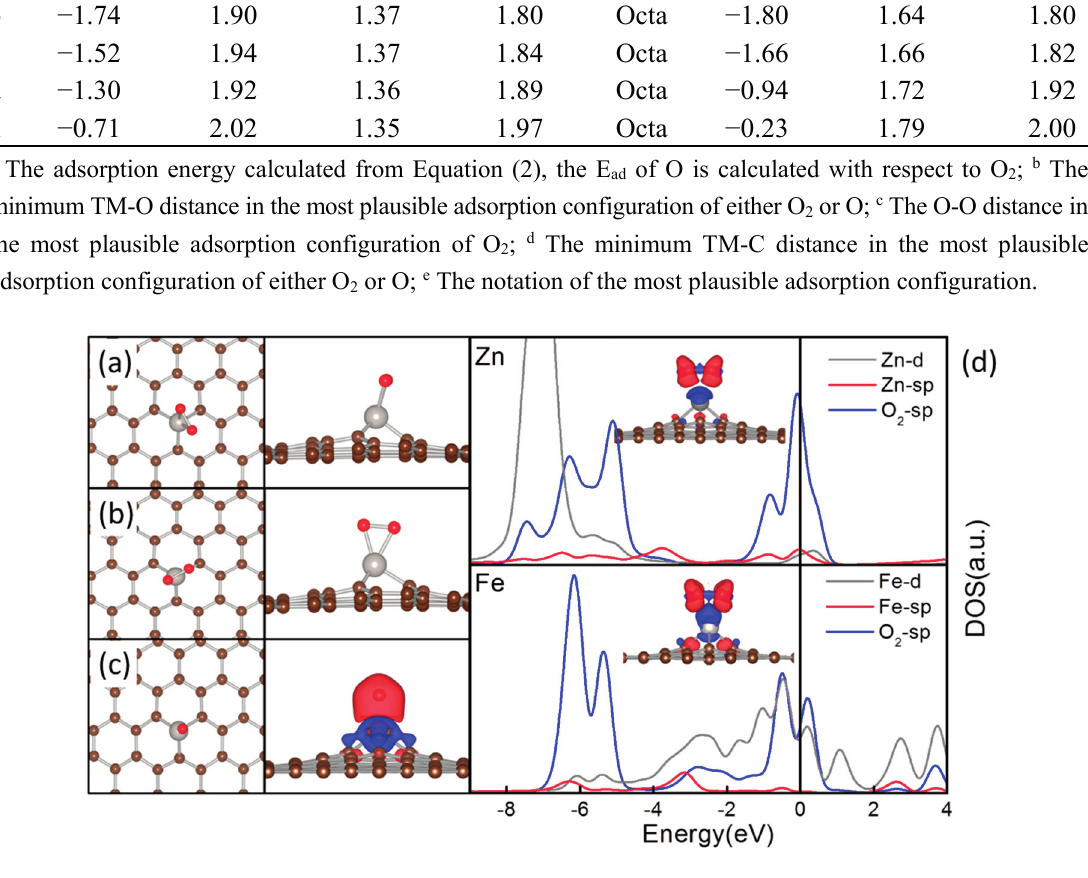
Figure 3. The top view and side view of Octa ( a ) and Tetr ( b ) configurations for O 2 adsorption on TM-MGs, the top view of the configuration for O adsorption on Fe-MG and the corresponding contour plot of differential charge density ( c ); and the DOS curves of O 2 adsorption on Fe-MG and Zn-MG ( d ) in Octa. In structures, the C atoms are in brown, the TM atoms are in silver and the O atoms are in red. The contour plots of differential charge density for O 2 adsorption are shown as insets in ( d ). The charge accumulation regions are in red and the charge depletion regions are in blue. In ( d ), the DOS curves were aligned by the calculated E F that was set to